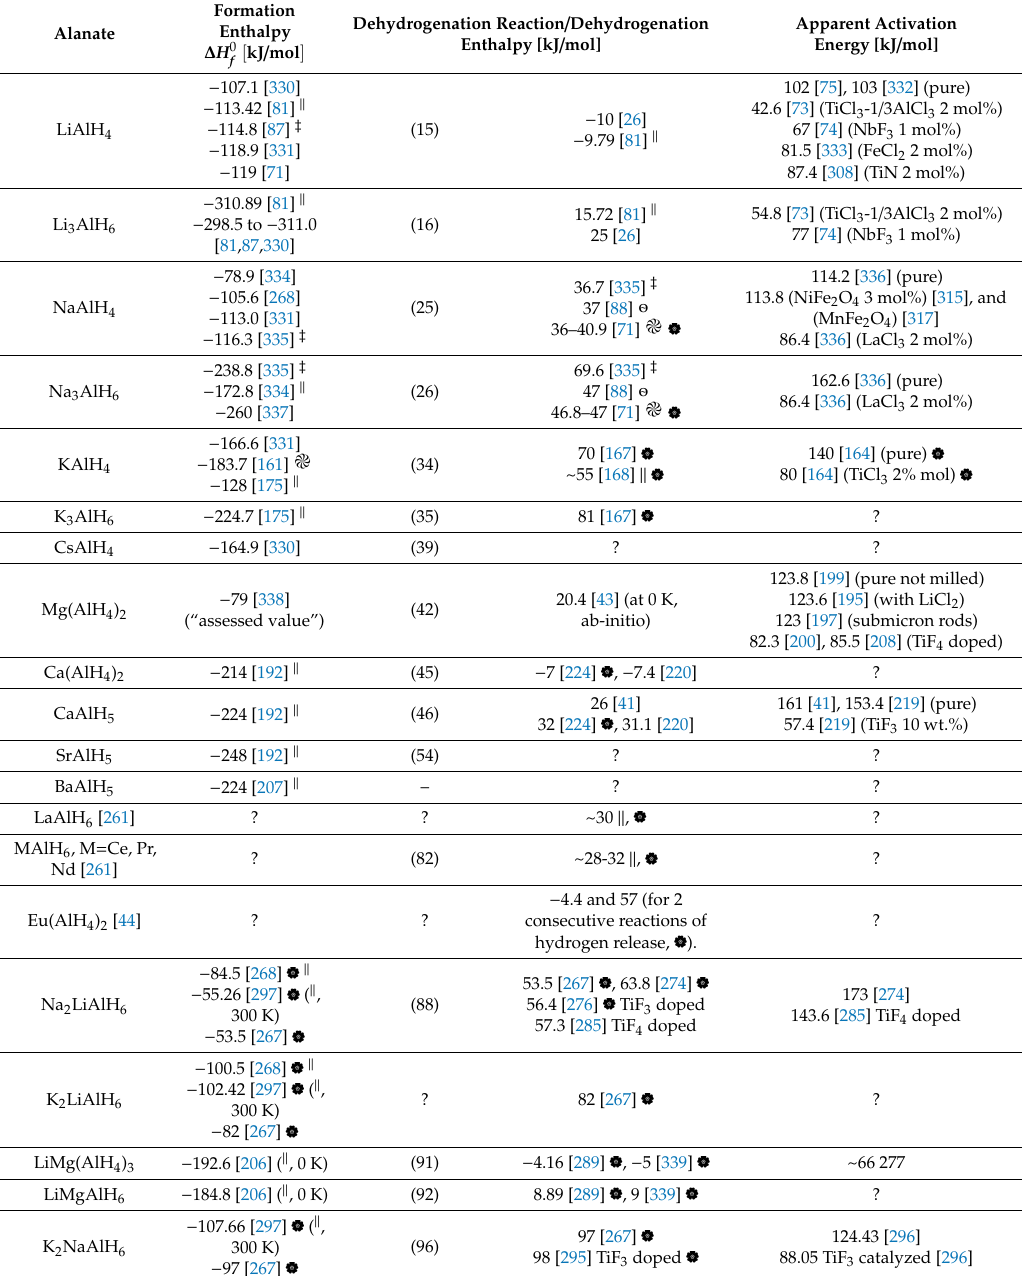
Table 21. Thermodynamic data of alanates.